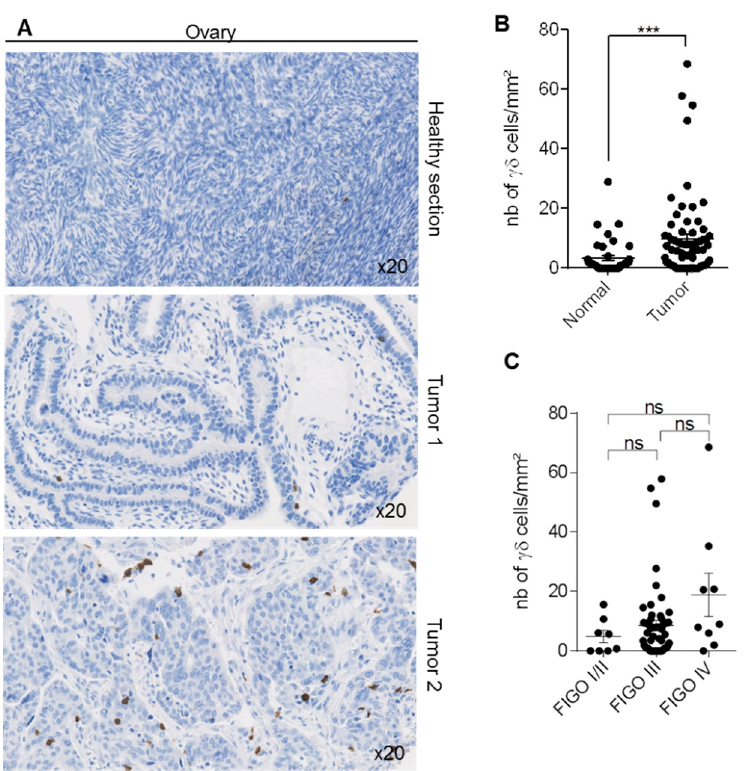
Figure 6. Detection of γδ T-cells in human ovarian samples. Immunohistochemical detection of γδ T-cells in 72 ovarian tumors and 49 paired normal ovarian samples. ( A ) The figure shows one representative normal ovarian tissue and two representative tumors with low and high γδ T-cell density. ( B ) Scatter plot comparing γδ T-cell density in normal and cancer tissue samples. ( C ) Scatter plot showing γδ T-cell expression in the 71 ovarian cancer samples, classified according to the FIGO stage. Data are the mean ± SEM. Ns: non-significant; *** p < 0.001 (Mann–Whitney test for panel B, Kruskal–Wallis with Dunn’s multiple comparison test for panel C).